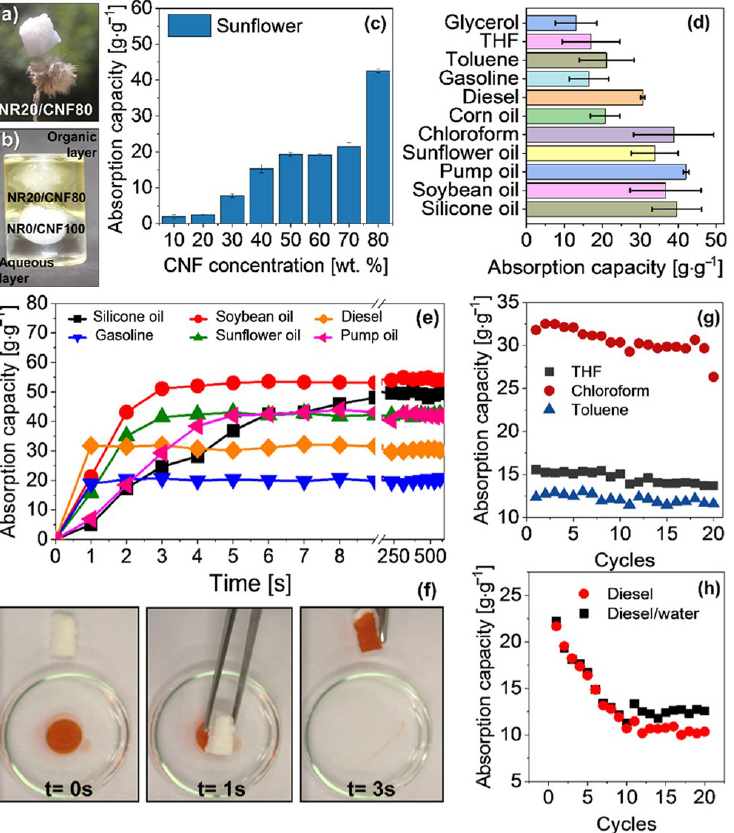
Figure 8. Absorption capacity and reusability of NR/CNF foams. Conceptual test: digital pho- tographs showing ( a ) ultralightweight foam placed on Taraxacum sp. and ( b ) hydrophobic affinity (NR20/CNF80, top) and hydrophilicity (NR0/CNF100, bottom). ( c ) Sunflower oil absorption as- say for different CNF contents (10–80 wt%). ( d ) Absorption capacity of NR20/CNF80 foams for different types of oils and organic solvents. ( e ) Kinetics for different oils and organic solvents for NR20/CNF80 foams from 0 to 600 s (the x-axis has a break between 10 and 100 s since the plateaus have reached). ( f ) Representative pictures of absorption kinetics for soy oil (orange). ( g ) Representa- tive curves of repeated cycles (0–20) for mass-based absorption capacity of the NR20/CNF80 foams at room temperature for organic solvents: THF, chloroform, and toluene. ( h ) Representative curves of the reusability test for diesel oil and diesel/water mixture. Reproduced with permission